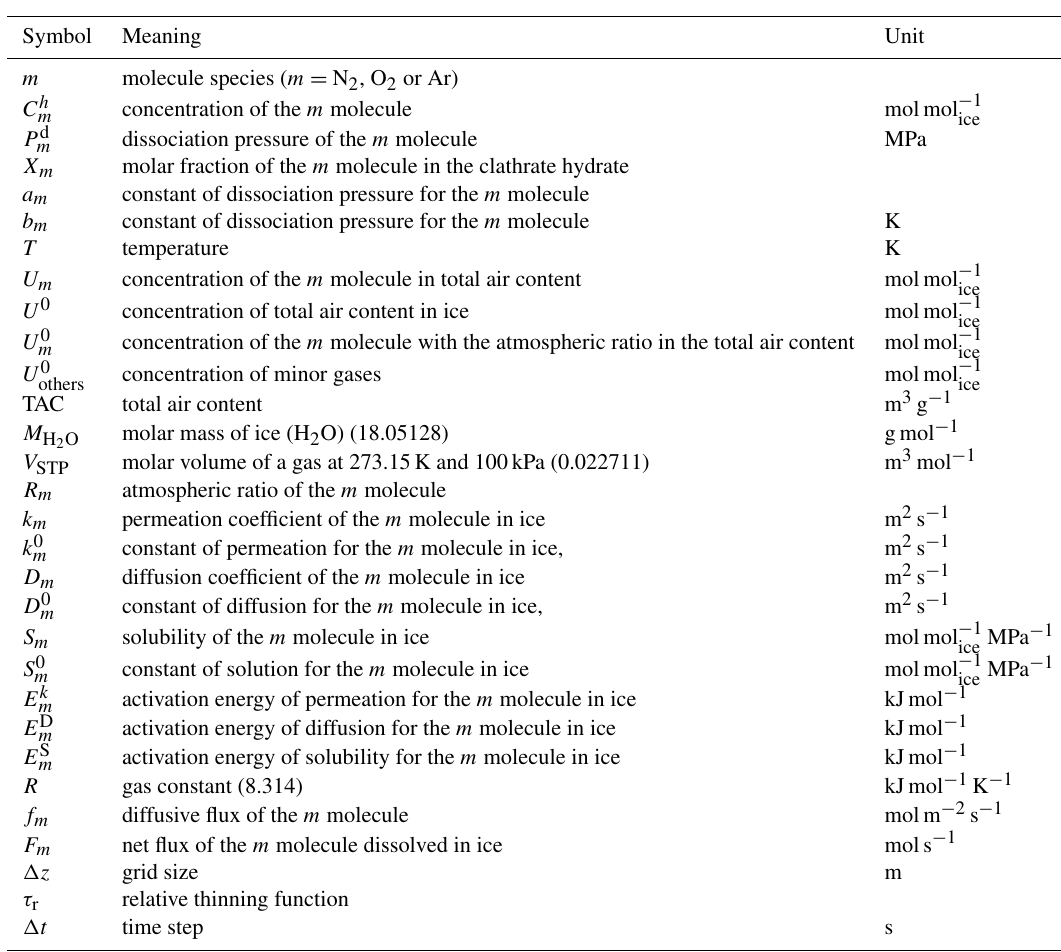
Table A1. List of